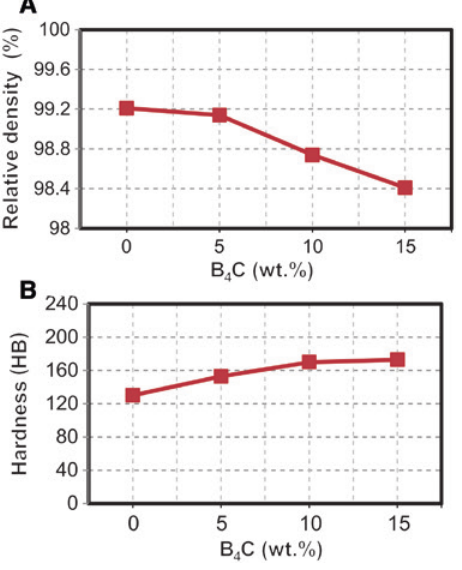
Figure 3: (A) Density values of MMC samples and (B) hardness vari- ations depending on the increasing reinforcement amount.